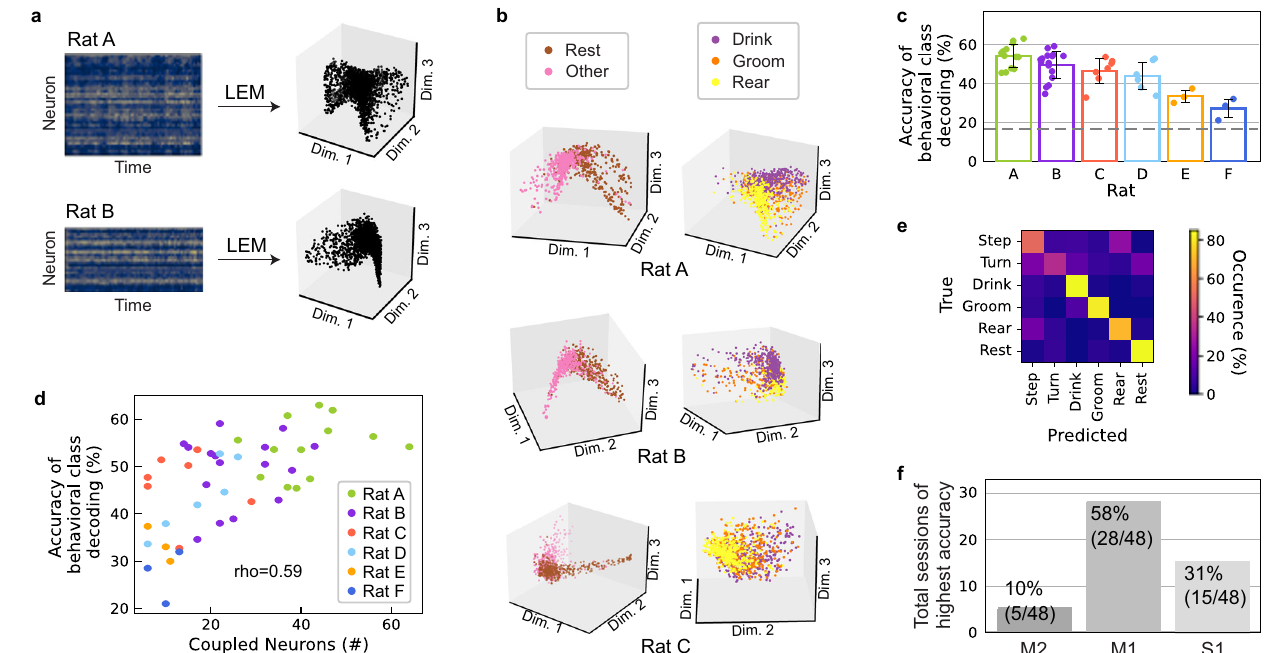
Fig. 2 | Behavioral classes can be decoded from low-dimensional neural struc- tureswithin onesession.a Non-lineardimensionalityreductionthroughLEMwas performed on the neural data of each session separately. b In the low-dimensional space, different behaviors were distinguishable in as few as three neural dimen- sions. Left panel: The fi rst dimension clearly differentiated between rest and movement (all other behavioral classes). Right panel: The second and third dimensionsplayed aprimaryroleincodingthedifferencebetweenpaw-andhead- relatedbehavior(rearvs.drink).OnesessionforeachofRatsA,B,andCisdepicted. c Classi fi cation accuracies for the six behavioral classes given low-dimensional neural input were above-chance level for the sessions for all six rats. The gray